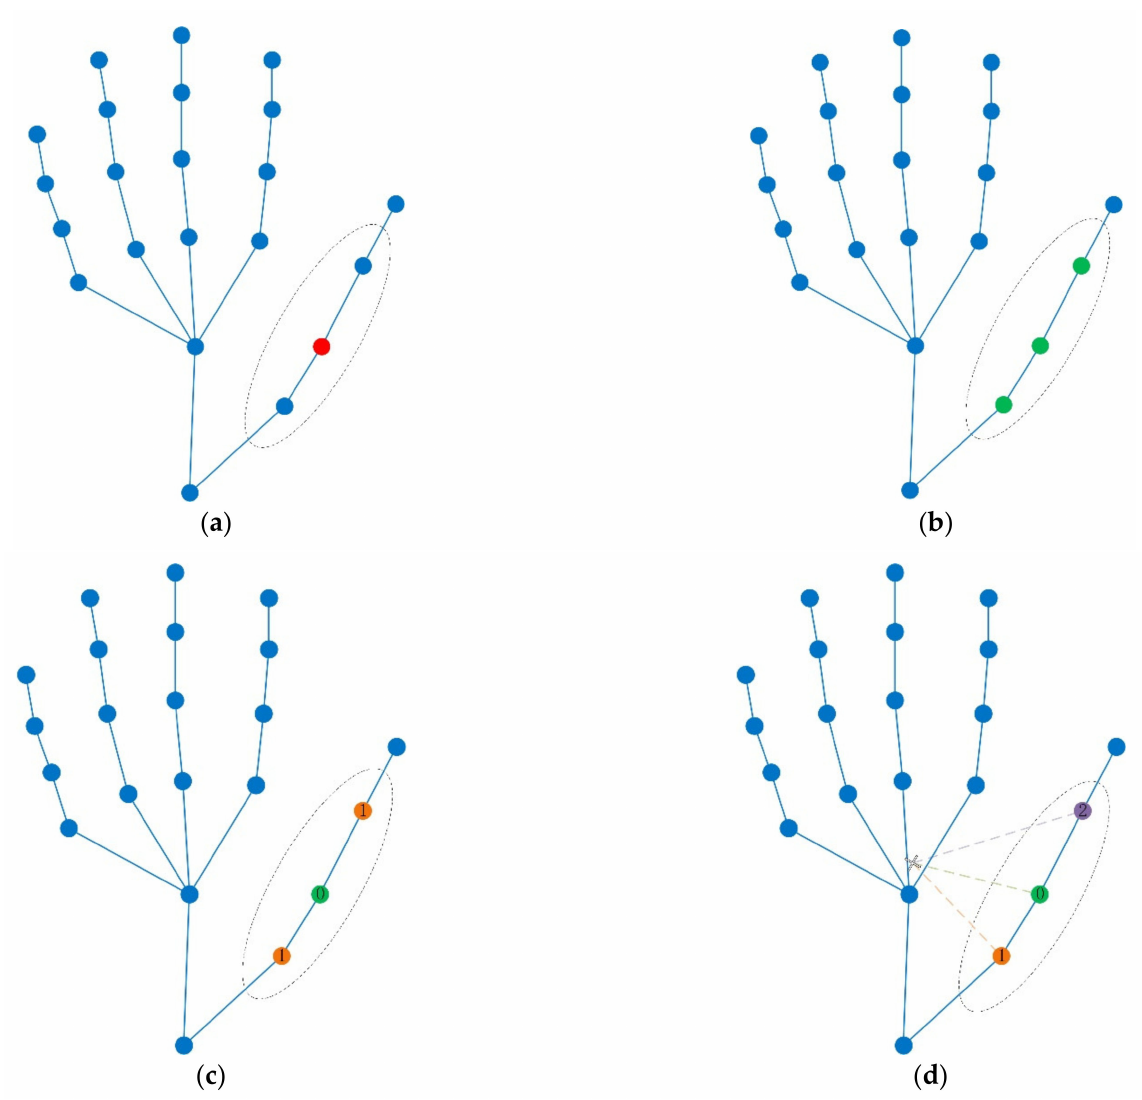
Figure 5. Original partition strategy for constructing convolution operations. ( a ) Example frame of input skeleton; ( b ) Uni-labeling partitioning; ( c ) Distance partitioning; ( d ) Spatial configuration